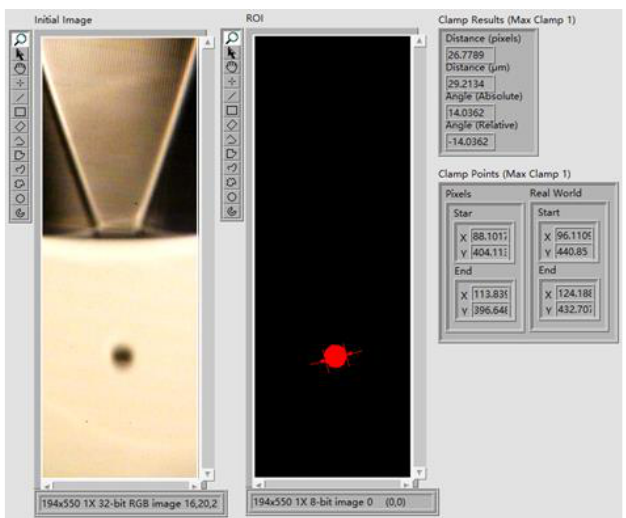
Figure 20. The front panel of the image processing and measurement program.